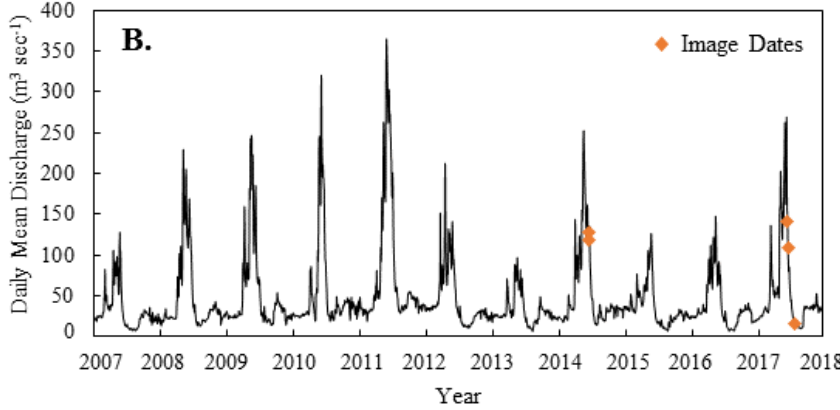
Figure 2. ( A ) The monthly Palmer Hydrological Drought Index (PHDI) values for southwestern Montana over the past 10 years, converted to percentages based on the historical record (1895–2017). Stars indicate the PHDI value at the time of the pre- and post-restoration images; ( B ) The daily mean discharge for the Jefferson River near Twin Bridges, Montana (USGS Gage #06026500) downstream of the four restoration sites. Diamonds indicate the discharge value at the time of the pre- and post-restoration images.